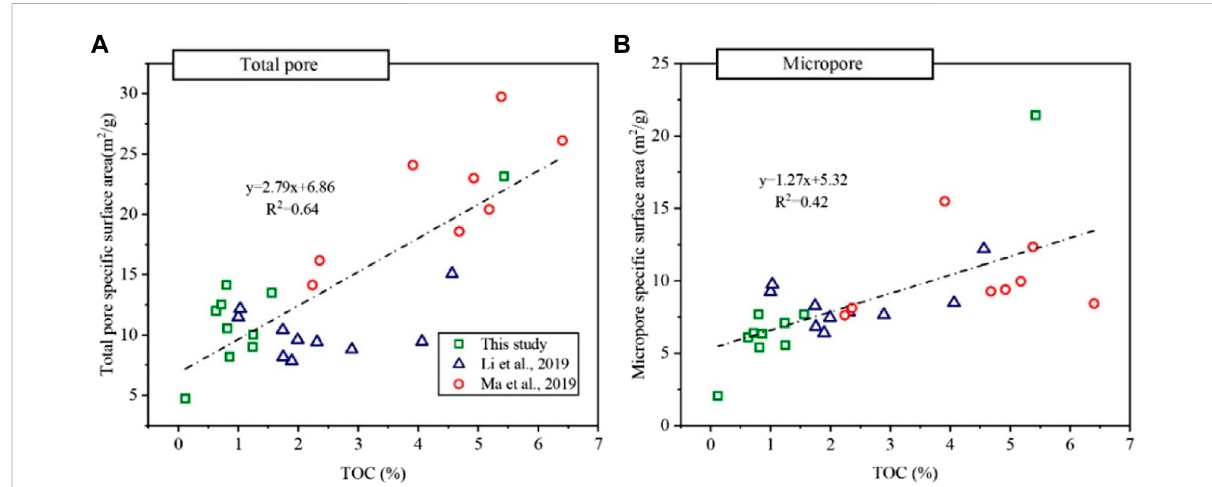
FIGURE 8 Relationship between TOC and pore speci fi c surface area of marine-continental transitional shales in different regions. (A) Total pore; (B)